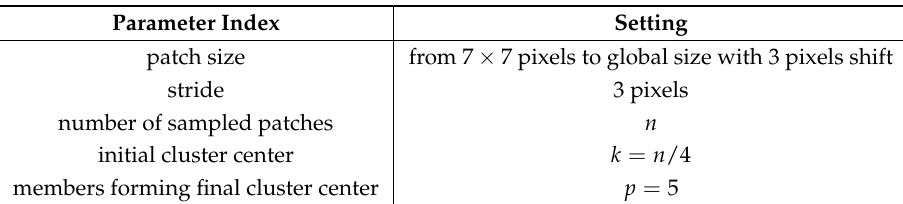
Table 1. Parameters for attribute